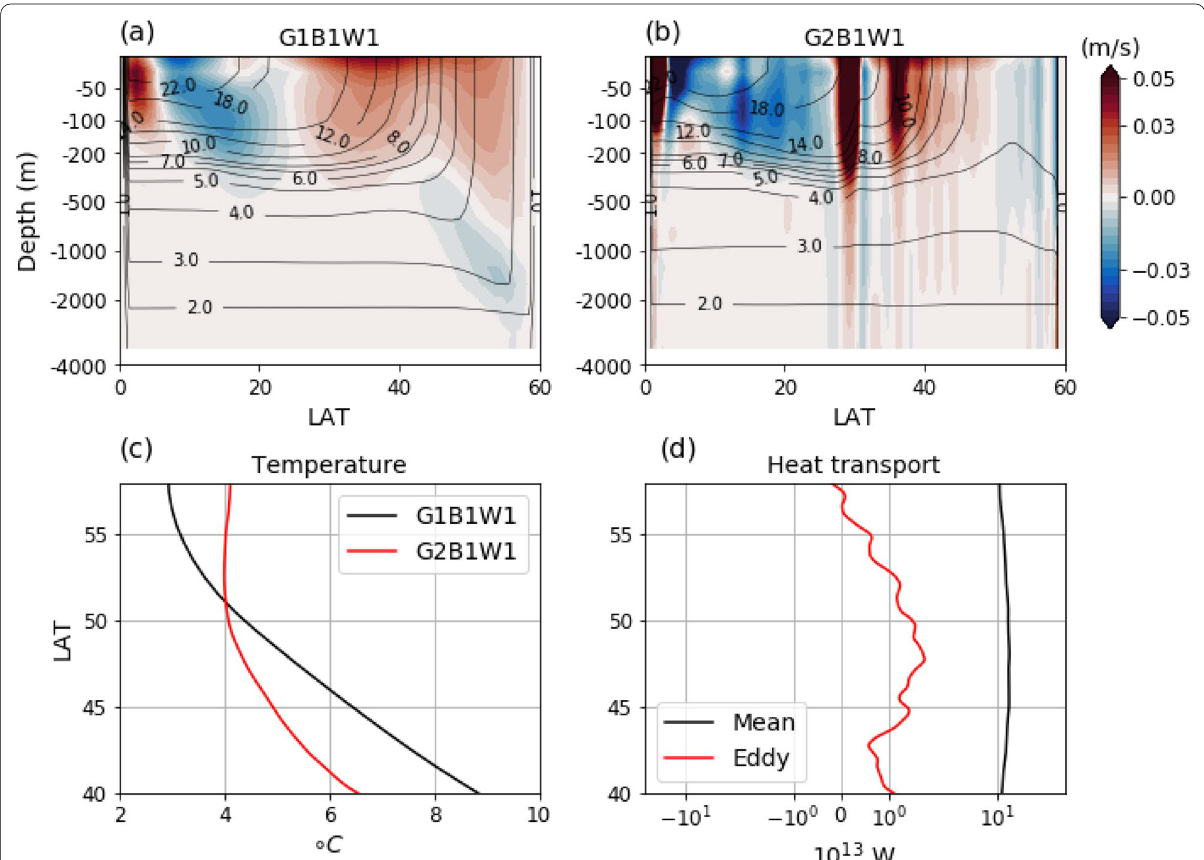
Fig. 3 The zonally averaged zonal velocity (colors) and temperature (contours) from experiments a G1B1W1 and b G2B1W1. c The zonally and vertically averaged temperature above 500 m in the subpolar region for the two experiments. d The zonally and vertically integrated northward heat transport above 500 m by the mean flow and eddies for